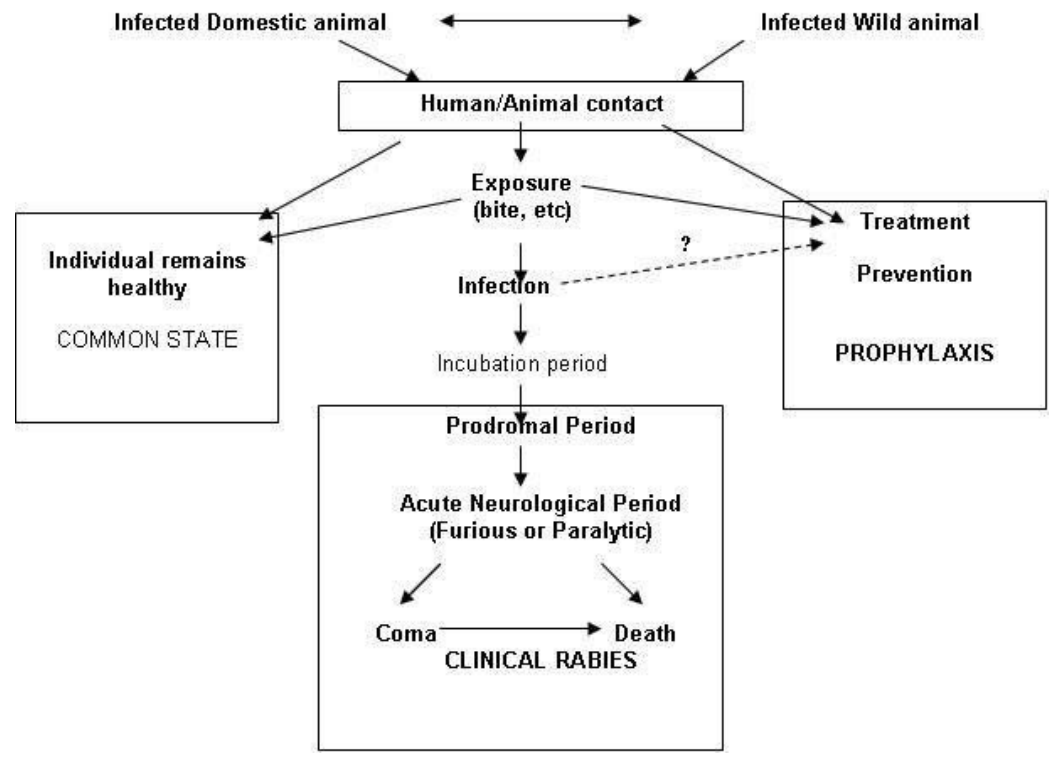
Figure 1: Course of rabies transmission. The first step is the transmission of the disease following exposure. The incubation period varies greatly. It ends when the virus begins to spread from the bite site to the surrounding peripheral nerves. Adapted from Baer et al. ,